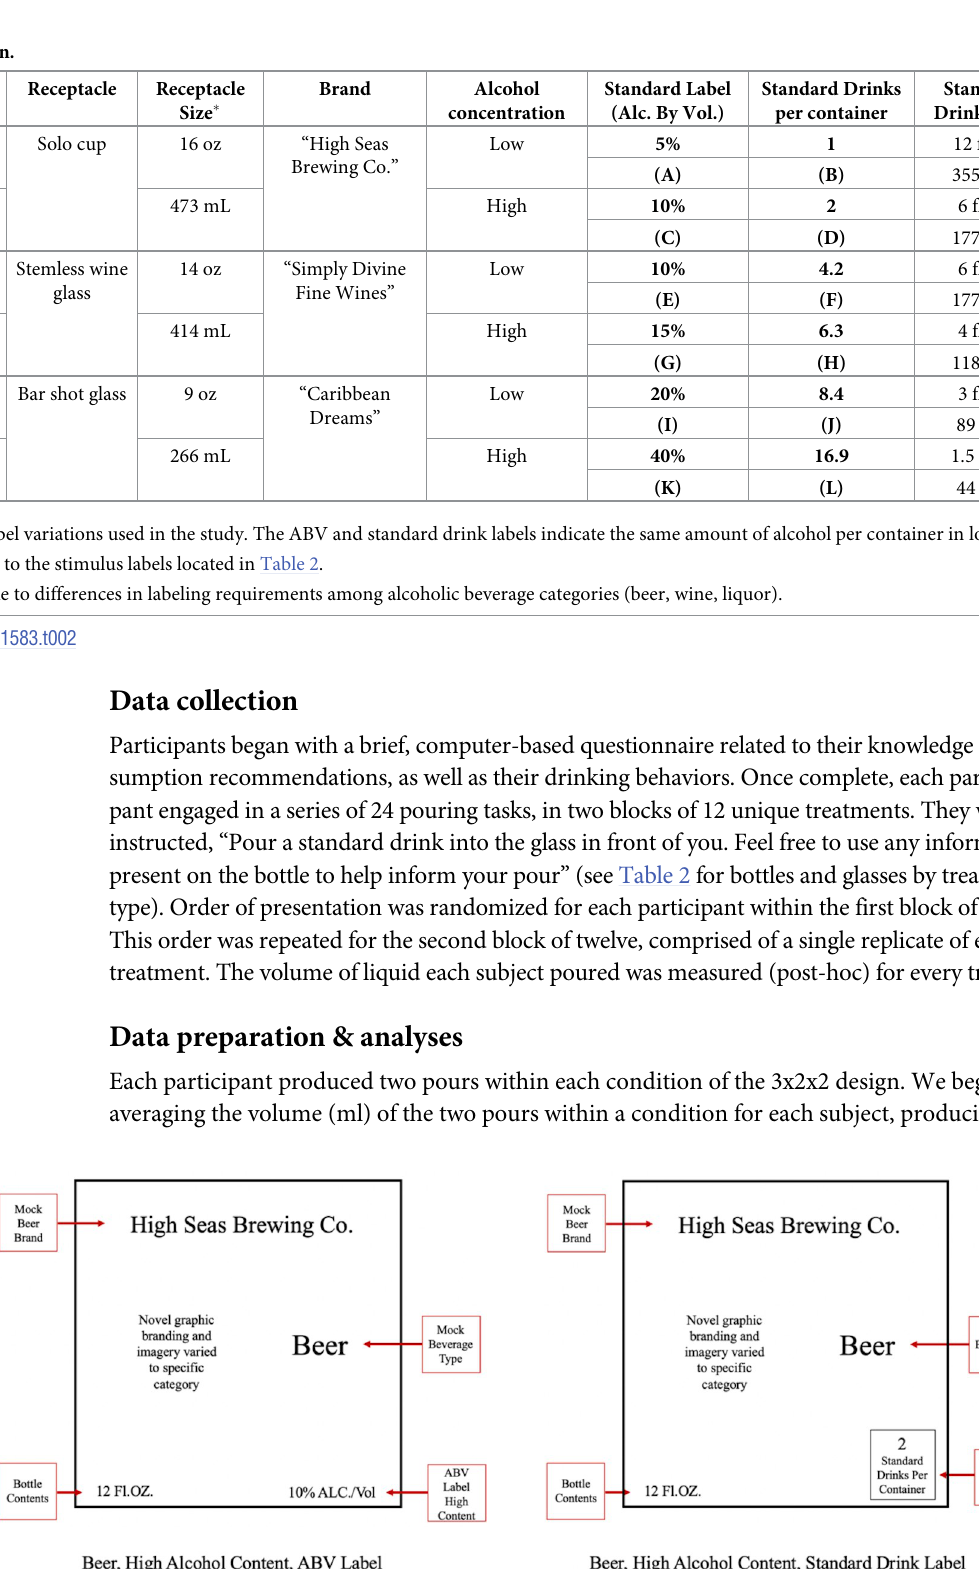
Table 2. Summary of stimulus design.